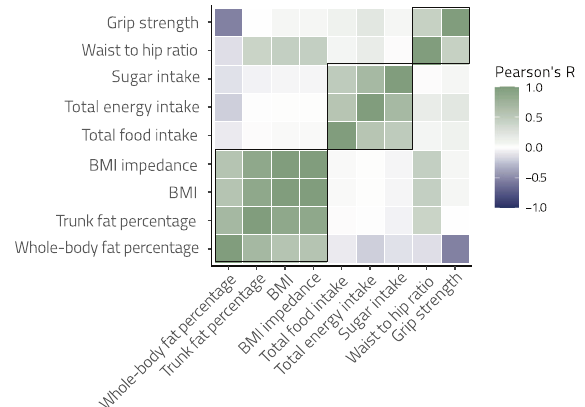
Fig. 1 Associations between continuous phenotypes. Hierarchical analysis revealed three main clusters of associations: a BMI/body-fat cluster, a dietary cluster, and a grip strength/waist-to-hip ratio cluster. All variables within clusters were signi fi cantly associated with each other (all p ’ s < 0.05,